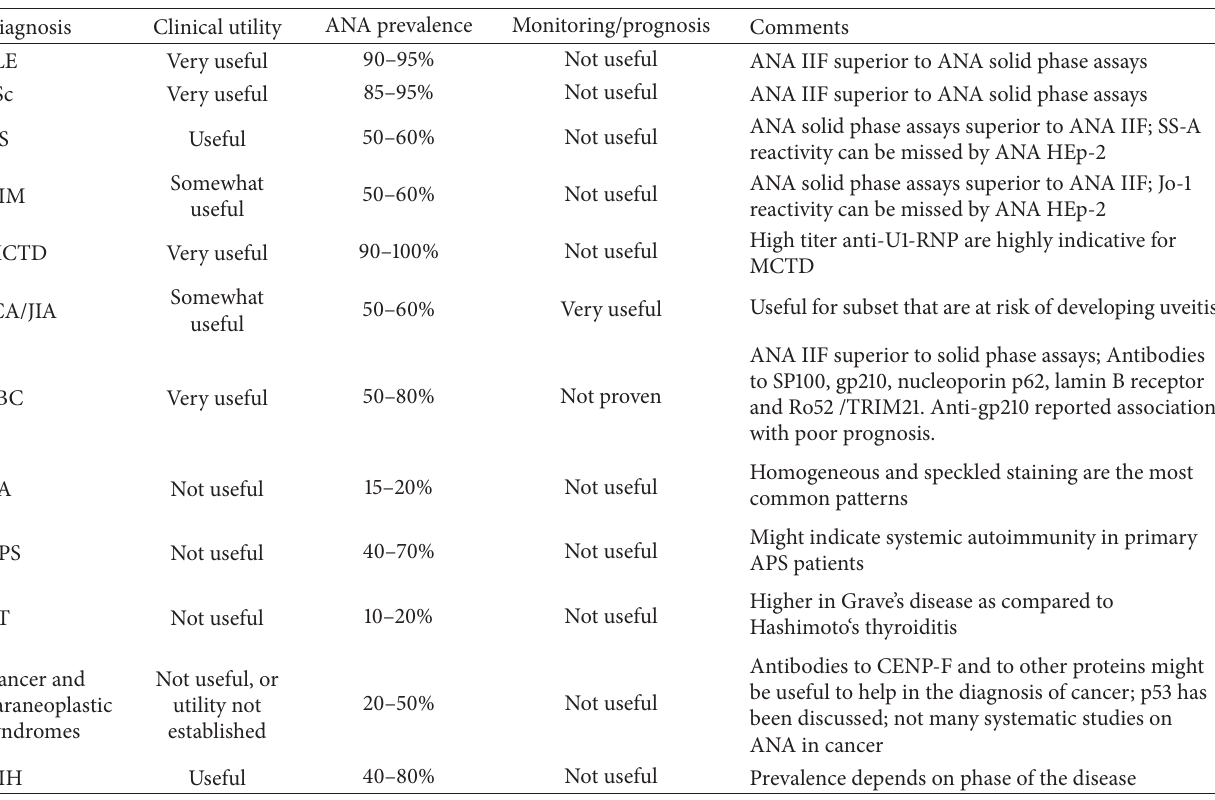
Table 4: Clinical utility of ANA testing in different